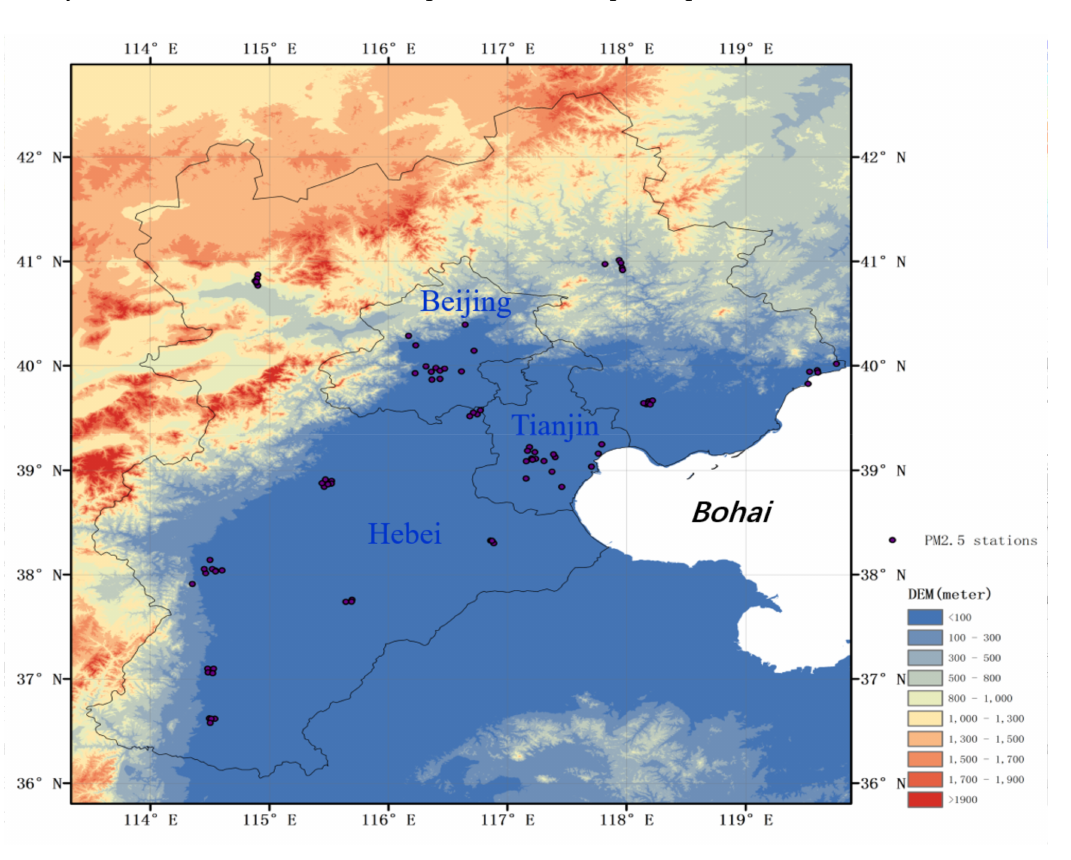
Figure 1. Spatial distribution of the 83 PM 2.5 monitoring sites in Beijing-Tianjin-Hebei (BTH) region. DEM denotes Digital Elevation